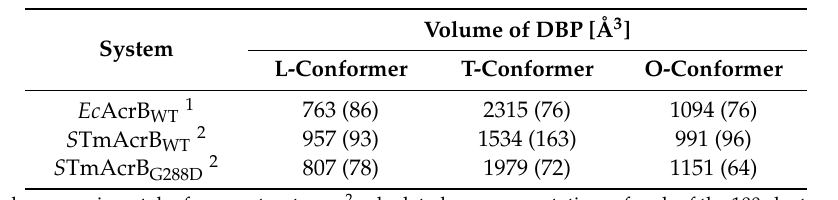
Table 2. Values of the volume of the deep- or distal-binding pocket (DBP) (standard deviations in parentheses) in each conformer of AcrB, measured on the E. coli AcrB WT reference structures and on the molecular dynamics (MD) trajectories of S. Typhimurium AcrB WT and AcrB G288D (see Materials and